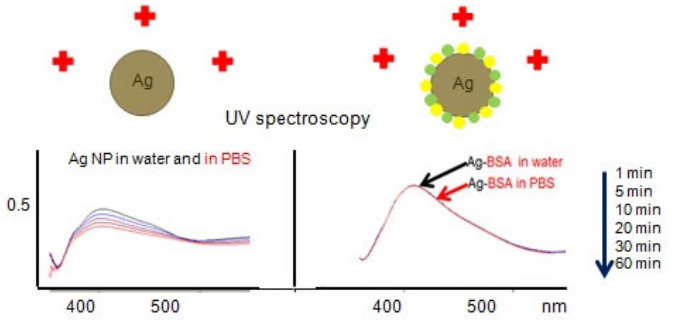
Figure 1. Comparison of stability of citrate coated AgNP (left panel) and the same AgNP conjugated with bovine serum albumin (BSA) (right panel) in water and phosphate buffer solution (PBS) by UV–VIS spectroscopy.